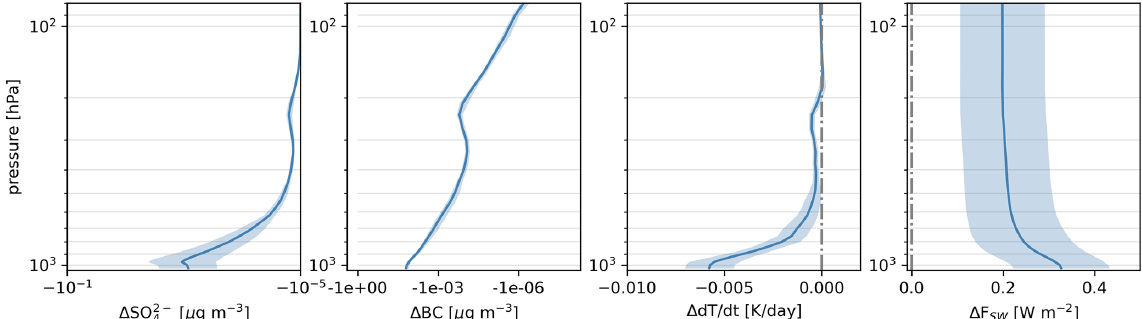
Figure 6. Vertical profiles of the difference in monthly mean sulfate mass concentration (SO 4 2 − ), black carbon mass concentration (BC), heating rate (d T/ d t ), and net shortwave flux ( F SW ) between the reduced emission scenario RED and the standard emission scenario BASE. Shortwave flux and shortwave heating are derived under clear-sky conditions. The shading indicates 1 standard deviation of the monthly mean difference. Note the logarithmic horizontal axis for the two plots on the